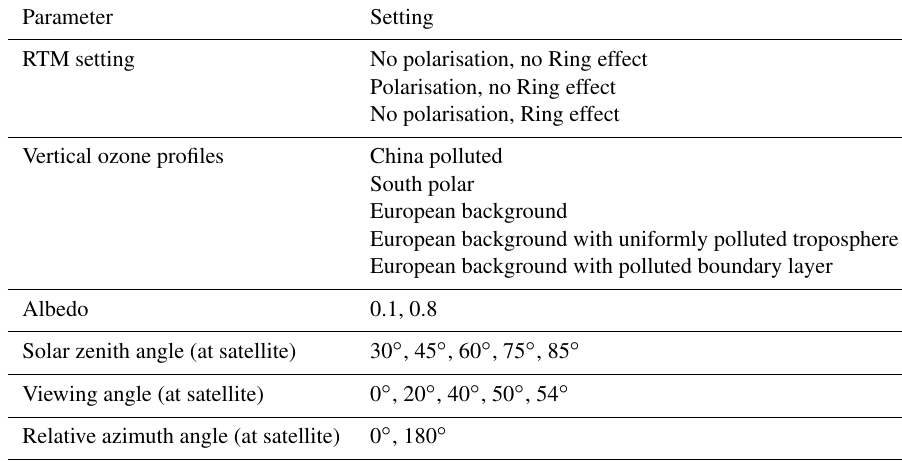
Table 2. Input parameters for the generation of synthetic spectra.